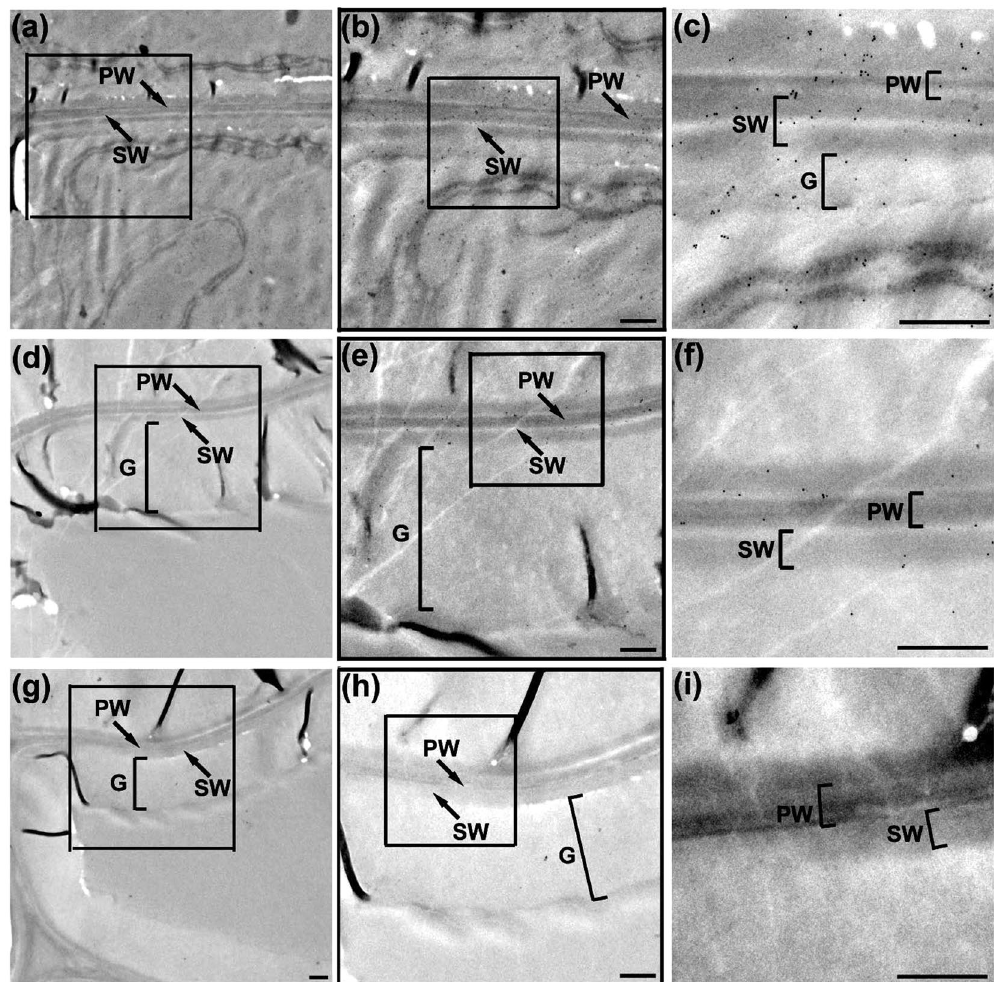
Figure 3. Immunocytolocalization of PtFLA6 in the G-fiber cells of TW xylem tissues. Transverse ultra thin sections of the xylem in the TW side were used for immunogold labeling TEM analysis. ( a , d , g ) Accumulation of PtFLA6 protein was examined in the differentiating G-fibers ( a ), the mature G-fibers ( d ) and the negative control ( g ), respectively. ( b , e , h ) Higher magnification images of the framed areas in ( a , d , g ), respectively. PtFLA6 labeling (black dots) was mainly detected in the differentiating G-fibers compared to that in the mature G-fibers. No labeling was seen in the control. ( c , f , i ) Higher magnification images of the framed areas in ( b , e , h ). PW, primary wall; SW, secondary wall; G, G-layer. Scale bars = 250